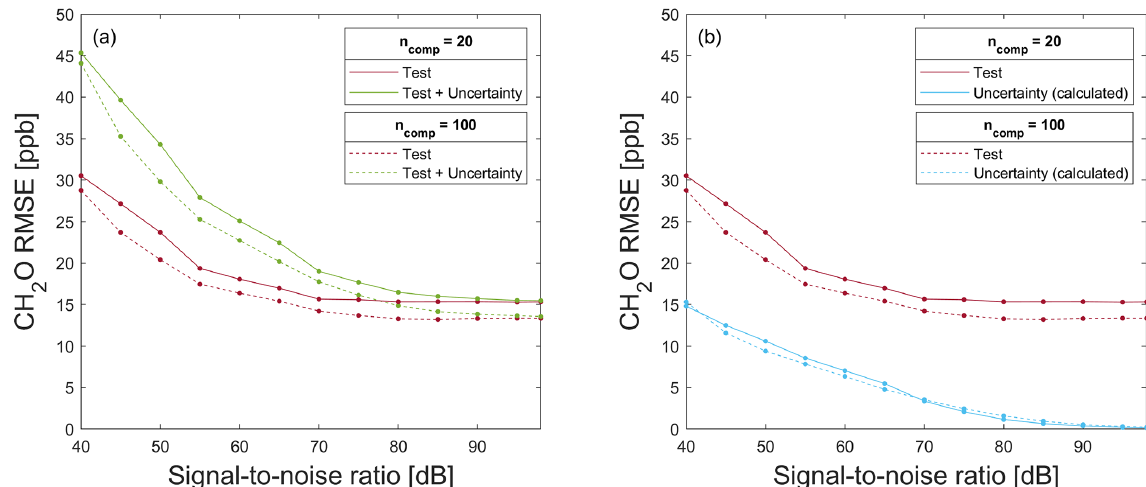
Figure 11. RMSE for testing a model trained with 80% noisy data for formaldehyde prediction on (a) 20% test data without (red) and with associated uncertainty values (green) and (b) 20% raw test data (red) and the calculated uncertainty RMSE (light blue) resulting from the difference in T + U − RMSE and T − RMSE for a different number of PLSR components. Note the magnification compared to Fig.